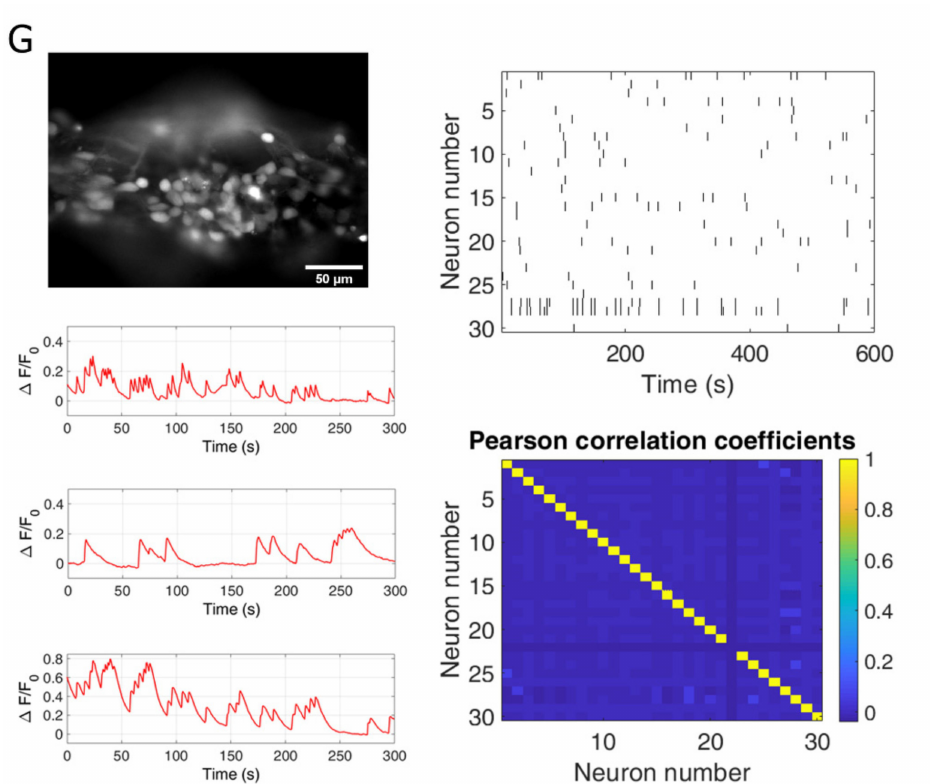
Figure 3. Functional analysis of the 3D bioprinted construct. ( A ) Single-cell patch-clamp recording of an iPSC-derived neuronal cell encapsulated in the 3D bioprinted construct at DPP7. ( B ) Representative schemeoftherecordingprotocolisshown. Theinwardsodiumcurrentsarehighlightedinthepurplebox and the permanent outward potassium currents are highlighted in the green box. ( C ) Average trace of the large inward voltage-dependent Na + currents. ( D ) Average trace of the outward voltage-dependent K + currents. ( E ) A single action potential evoked in current clamp recording is shown. The minimum current required to elicit firing was 10 pA, however more of the 50% of tested cells ( n = 9 out of 15) responded to 20 pA ( F ). ( G ) Calcium traces as a function of ∆ F / F 0 of cortical neurons isolated within the 3D network shown on the left at DPP7. On the right, a representation of the firing pattern and a relative heatmap of the Pearson correlation coe ffi cients within the cells of the same network are